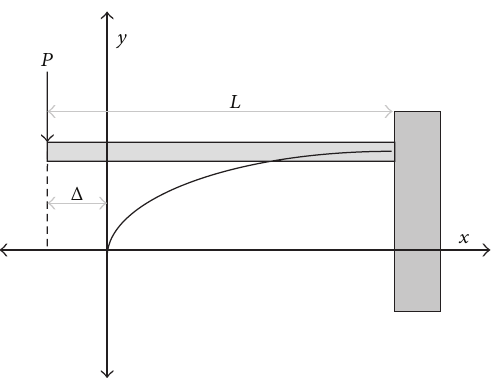
Figure 1: Cantilever beam with a concentrated load at the free